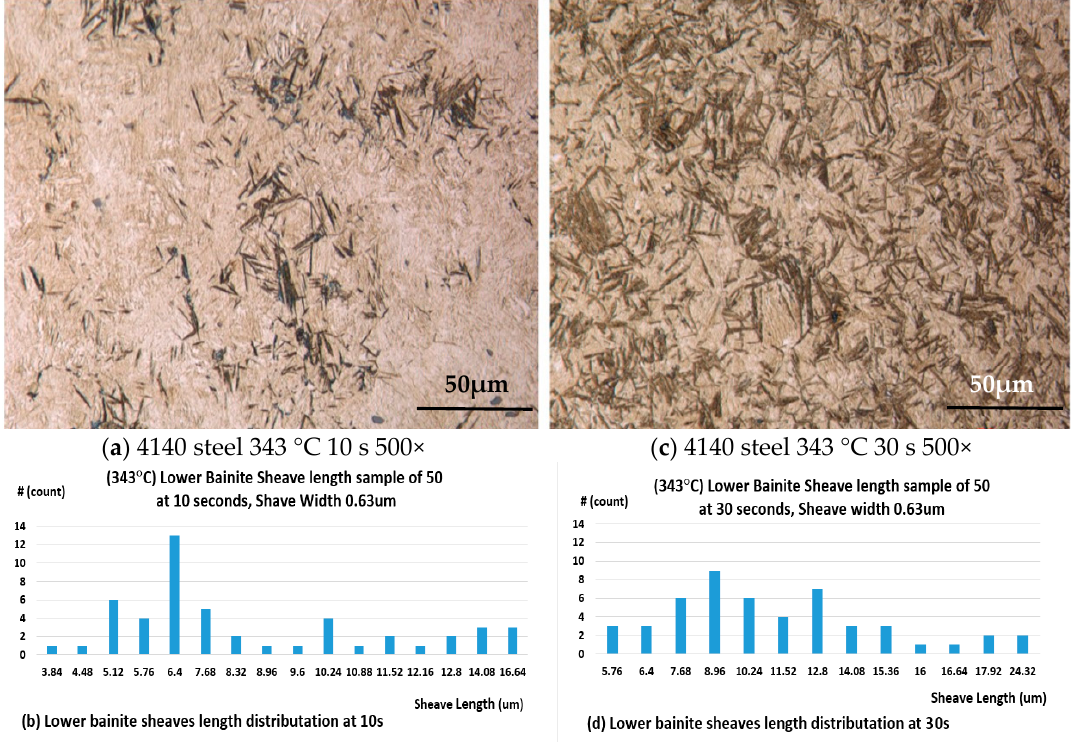
Figure 6. 4140 steel, 343 ◦ C, 10–30 s, half to full grown lower bainite sheaves, LM 500 × .